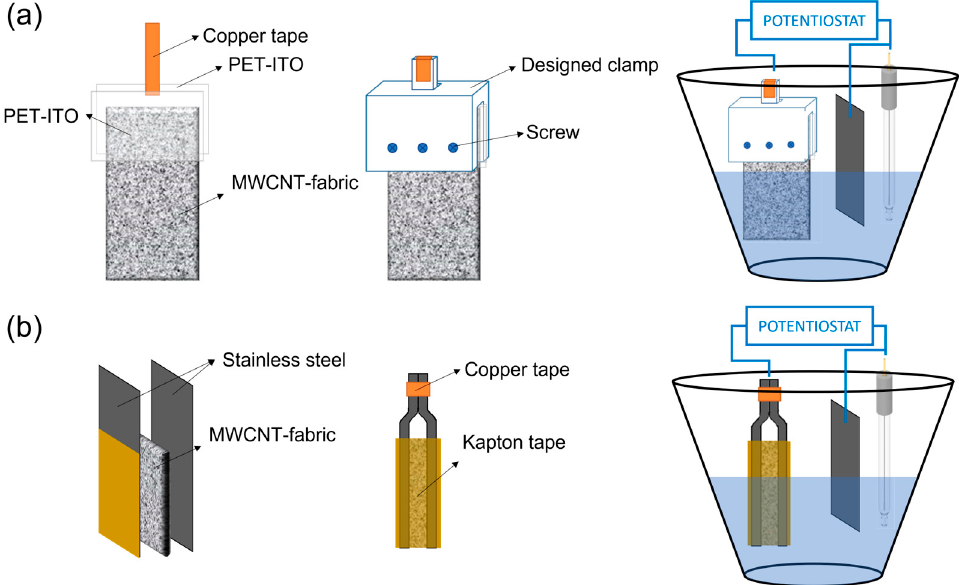
Figure 2. Clamps designed and electrochemical vessel for: ( a ) electrodeposition of PEDOT and PPy, and ( b ) electrodeposition of PANI on MWCNT coated fabrics.